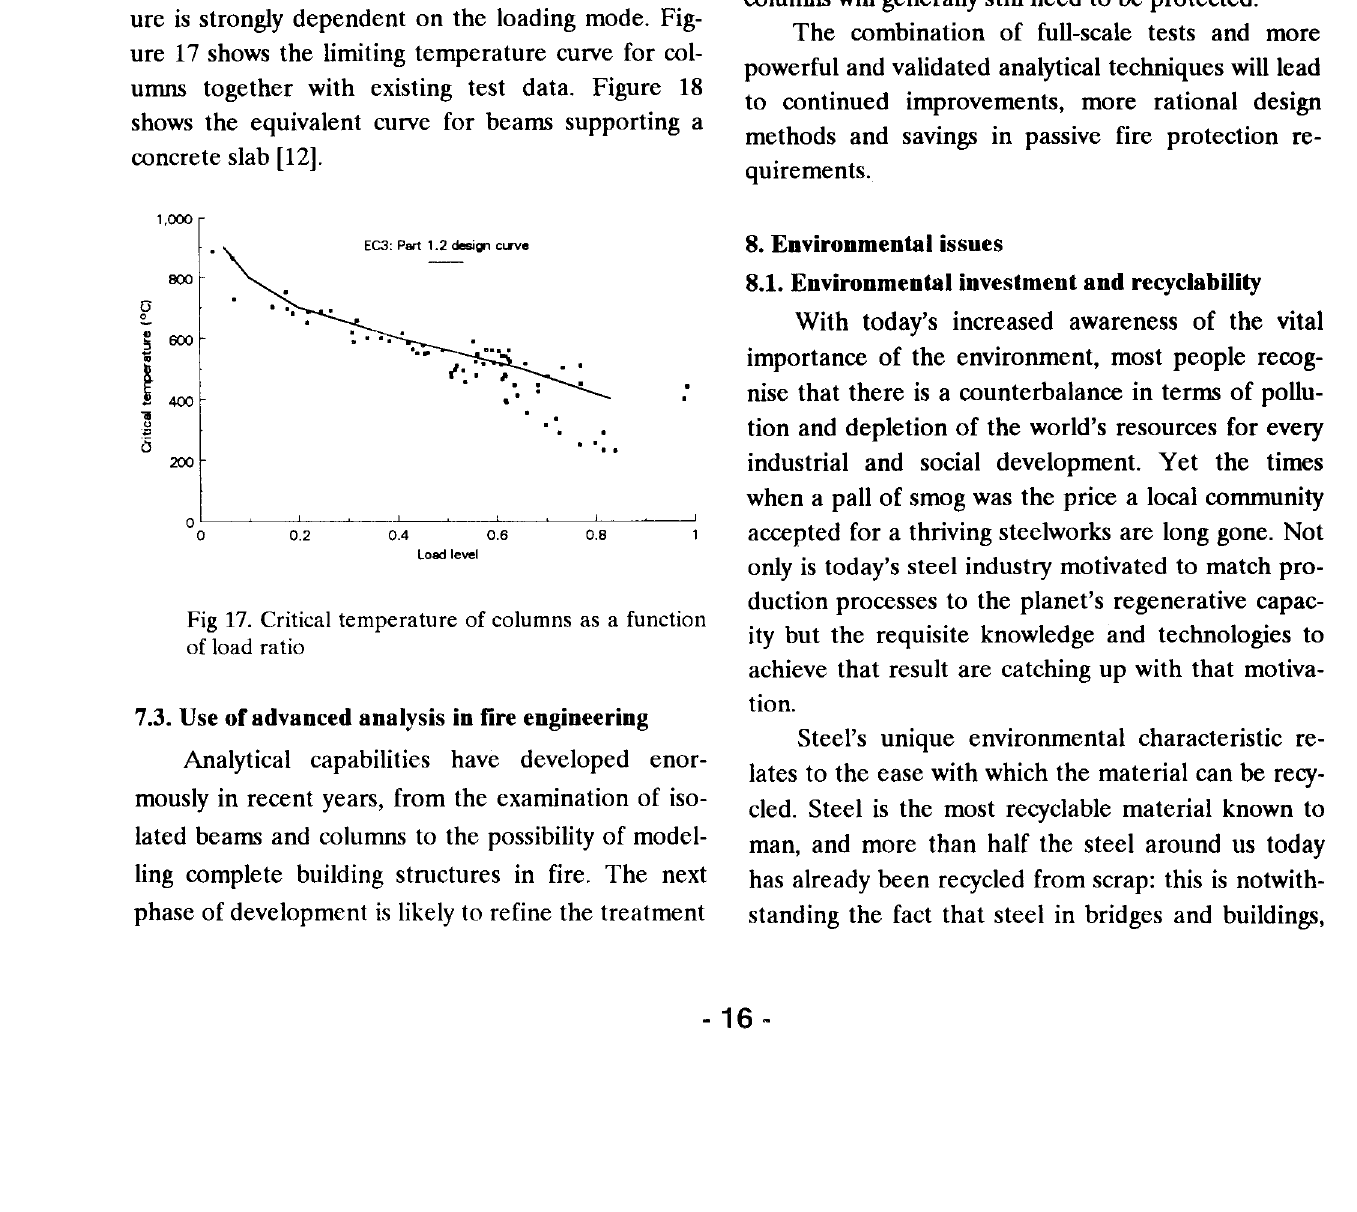
Fig 18. Critical temperature of beams as a func tion of load